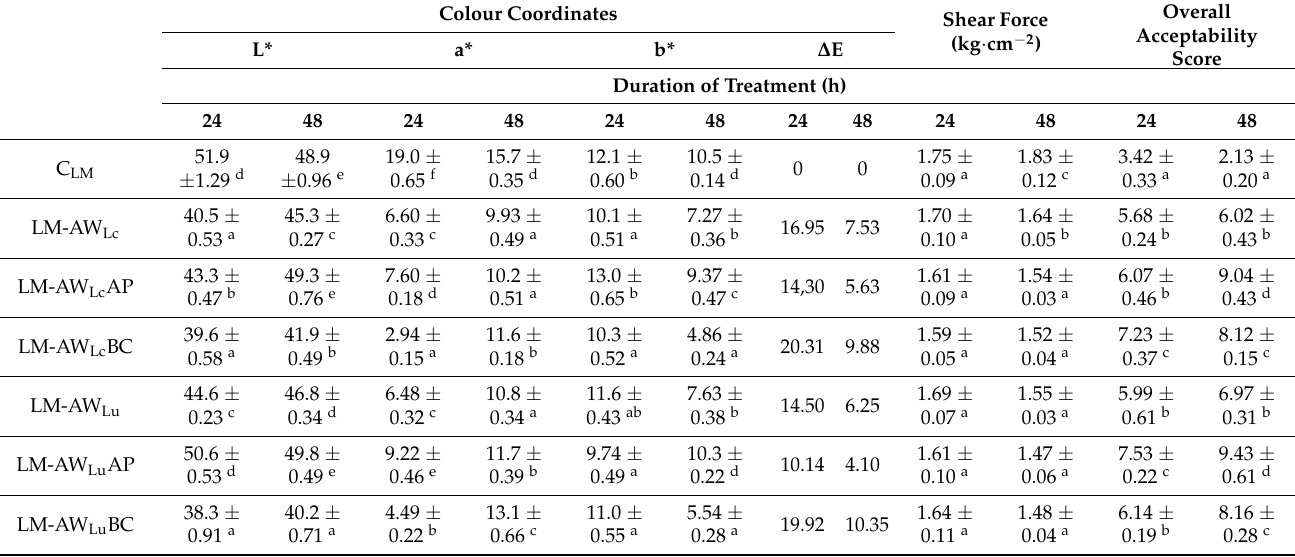
Table 7. The colour coordinates, tenderness, and overall acceptability of the lamb meat samples treated with the different